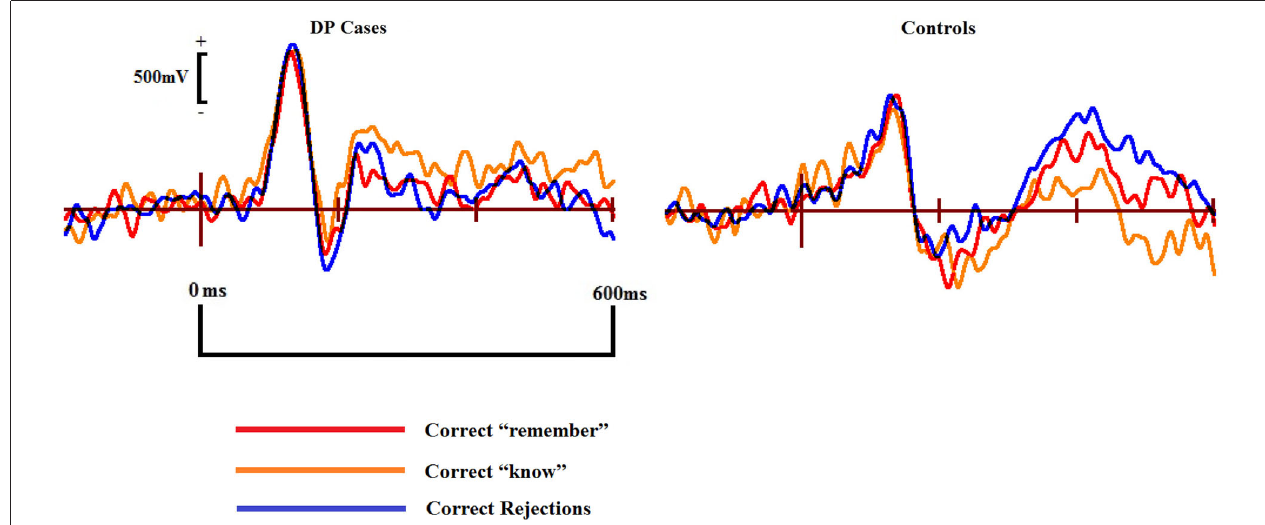
FIGURE 7 | ERPs of correct “remember” and “know” responses compared to correct rejections in the DP cases (left) and controls (right) from the inferior mid left anterior (ILA) region associated with familiarity for objects and words .